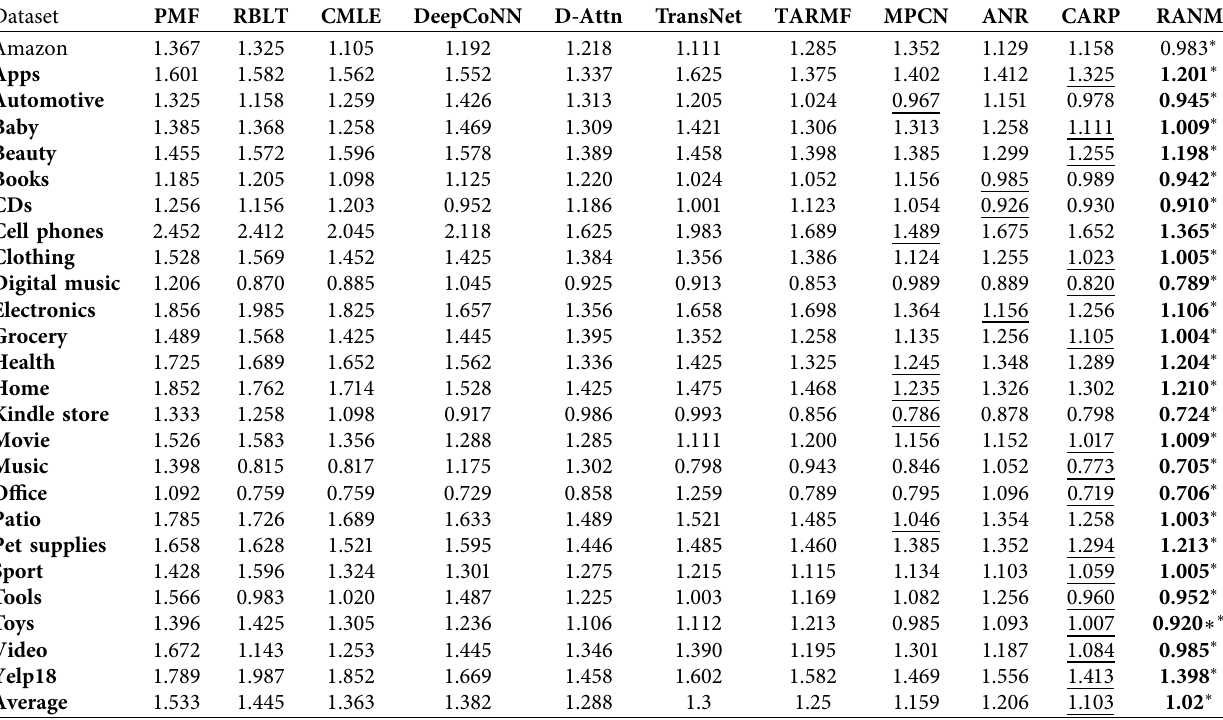
Table 3: Performance comparison in terms of